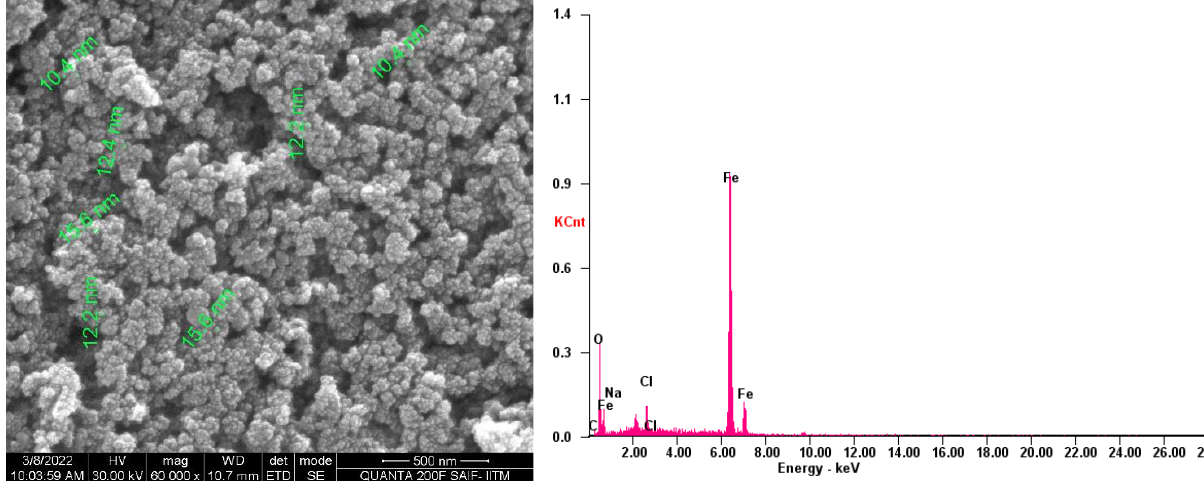
Figure 4. SEM and EDX analysis of Figure 4. ( a ) SEM and EDX ( b ) analysis of SPIONs.